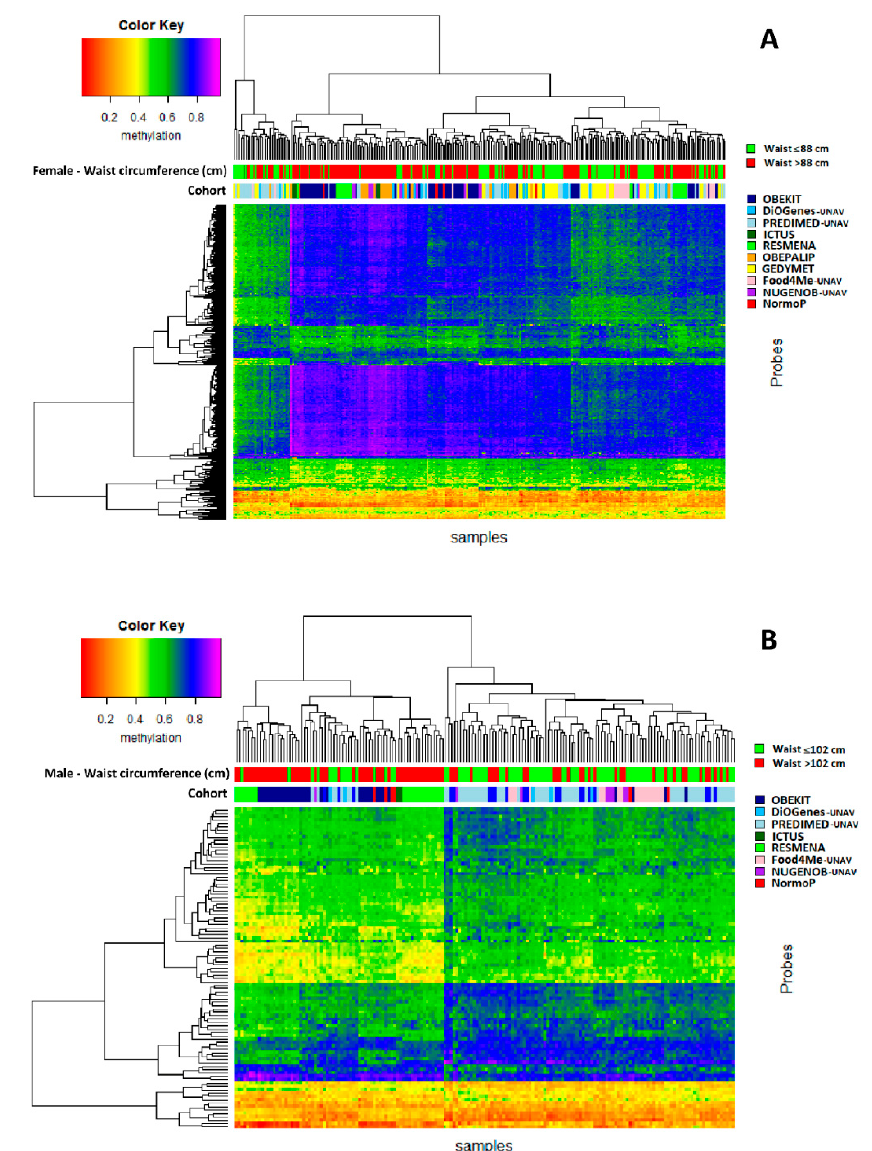
Figure 3. Heat maps representing the clusters between methylation levels (rows) and subjects from the di ff erent cohorts (columns). ( A ) Heat map of 375 CpGs selected by Student’s t -test between females with waist circumference ≤ 88 and > 88 cm. ( B ) Heat map of 95 CpGs selected by Student’s t -test between males with waist circumference ≤ 102 and > 102 cm. Significance: p < 7.47 × 10 –5 after Bonferroni correction.